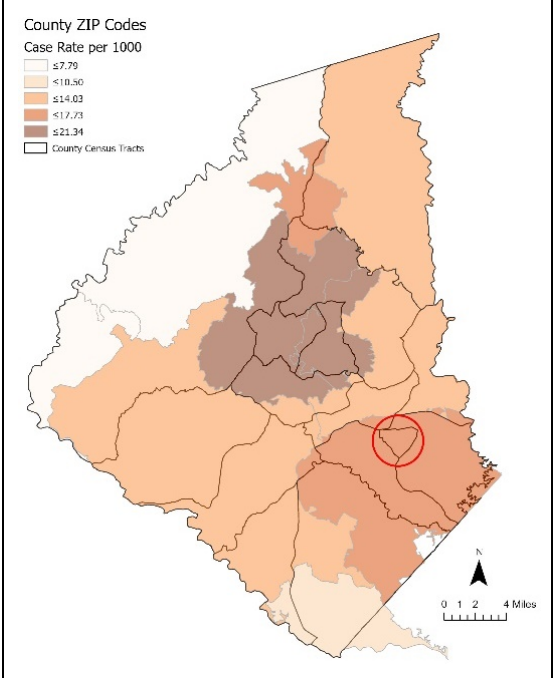
Figure 1. COVID Case Rate per 1,000 by ZIP